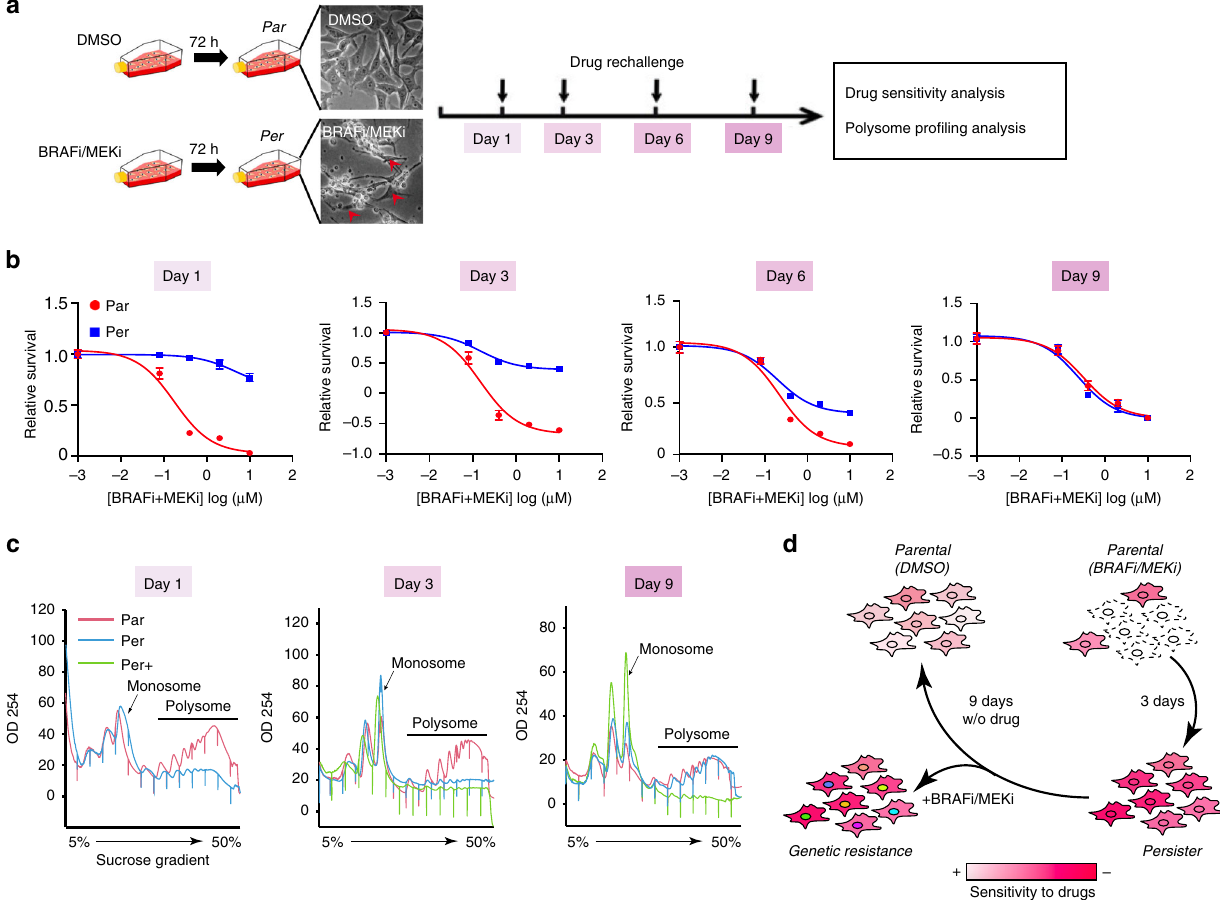
Fig. 1 Melanoma persister cells have altered translation activity. a Schematic of melanoma persister cell generation and subsequent analyses. Par: parental cells treated with dimethylsulfoxide (DMSO), Per: persister cells marked as red arrows. b Reversible drug tolerance of persister cells upon BRAFi/ MEKi removal. Persister and parental cells were re-challenged with BRAFi/MEKi treatment on the indicated days and drug sensitivity was analysed by WST-1-based cell viability assay. c Polysome pro fi les of persister cells at various time points, assessed by 5 – 50% sucrose-gradient ultracentrifugation. Per + represents persister cells upon continuous BRAFi/MEKi exposure. d Schematic view shows that persister cells re-acquire similar drug sensitivity as parental cells upon BRAFi/MEKi removal. Upon continuous drug exposure, persister cells can serve as a reservoir for the development of genetic acquired resistant cells. The raw data of b are available in Source